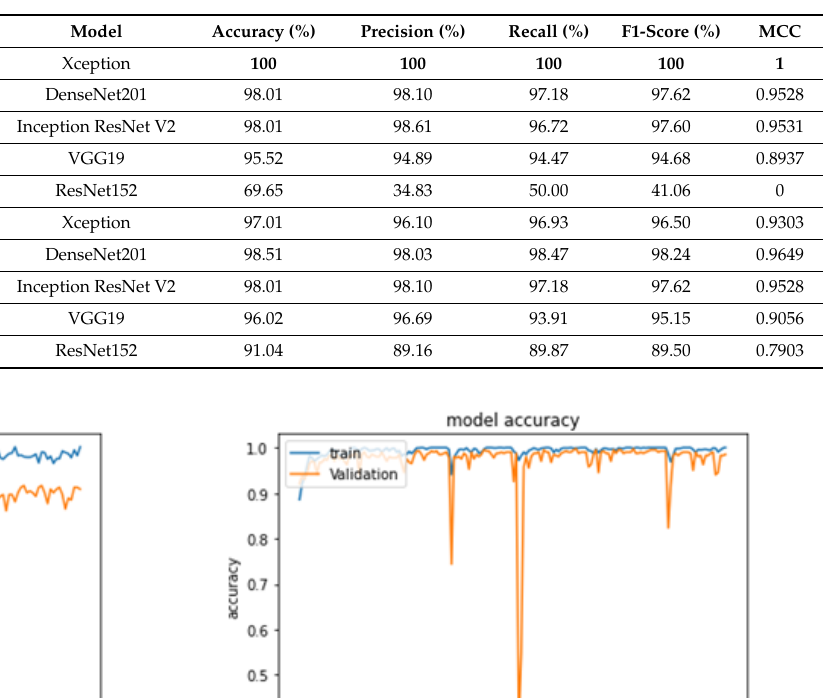
Table 7. Results of 200× magnification factor in binary classification mode; the highest results are shown in bold.